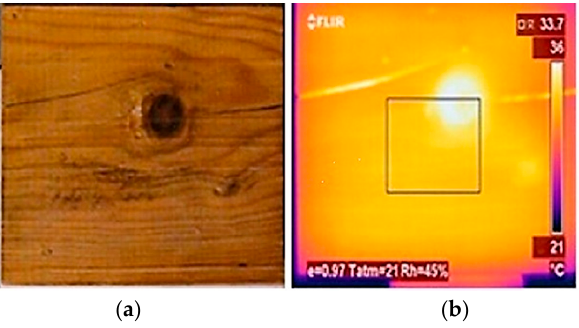
Figure 2. Pine sample: ( a ) photograph and ( b ) IRT thermogram (active mode) [50].